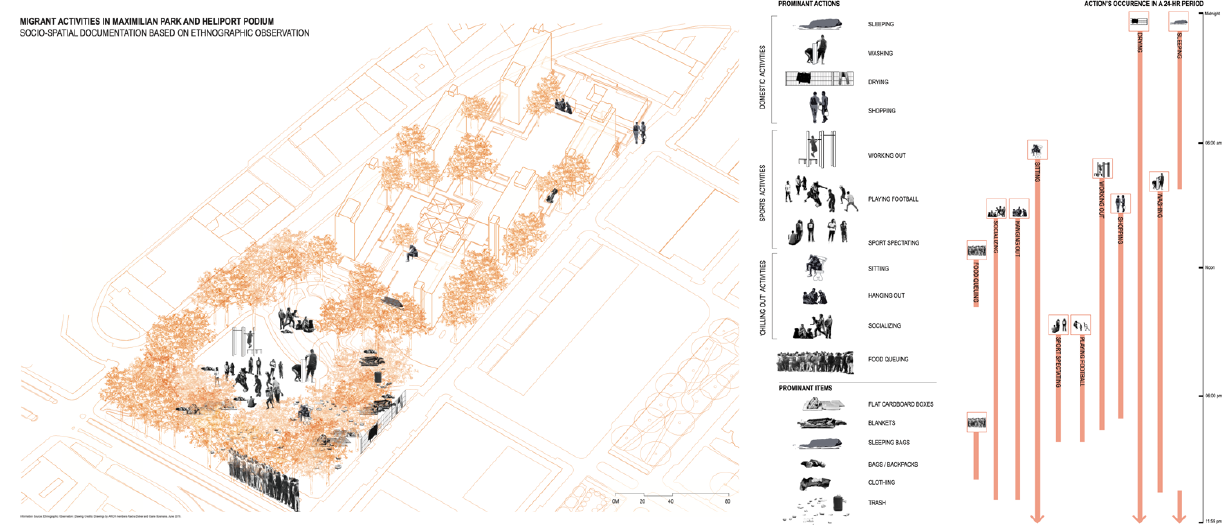
Figure 1. Migrant activities in Maximilian Park. Source: Bosmans & Daher